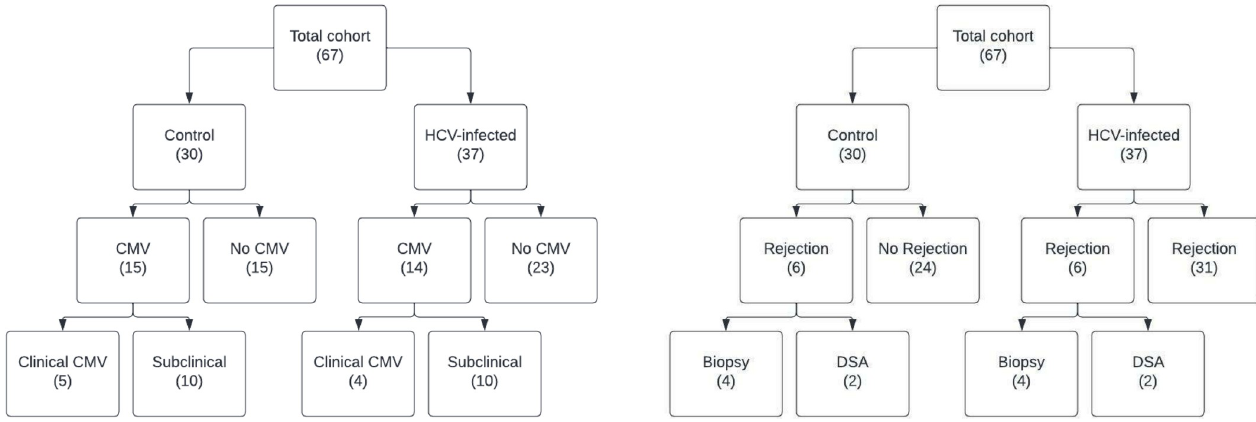
Fig 1. Cohort diagram. Cohort diagram of all enrolled study participants, with breakdown into CMV (left) and rejection (right) subgroups.